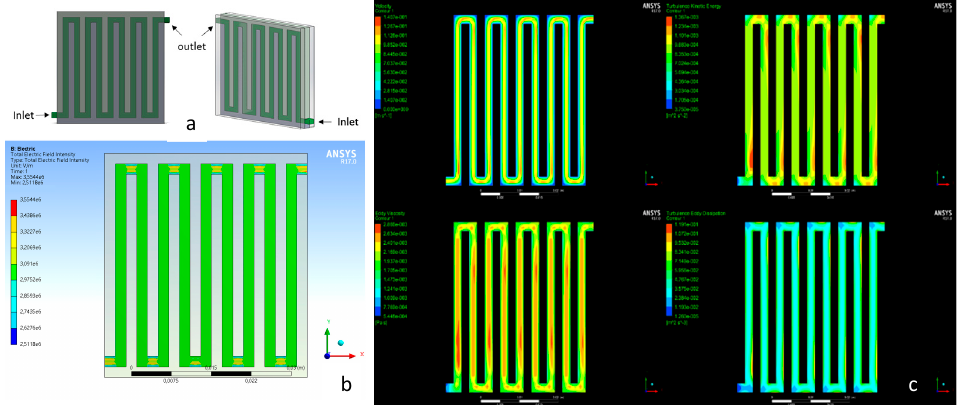
Figure 1. ( a ) Continuous-flow electroporation chamber with square turns; ( b ) electric field intensity distribution in the chamber; ( c ) fluid flow characteristics inside the chamber with rectangular turns.